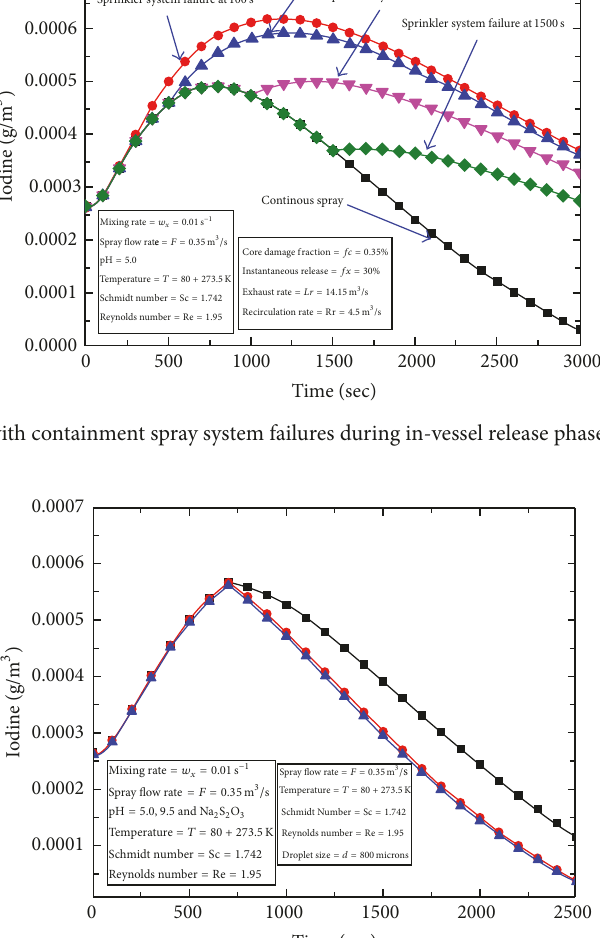
(Figure 16). An insignificant change in gas phase ( 𝐾 퐺 )